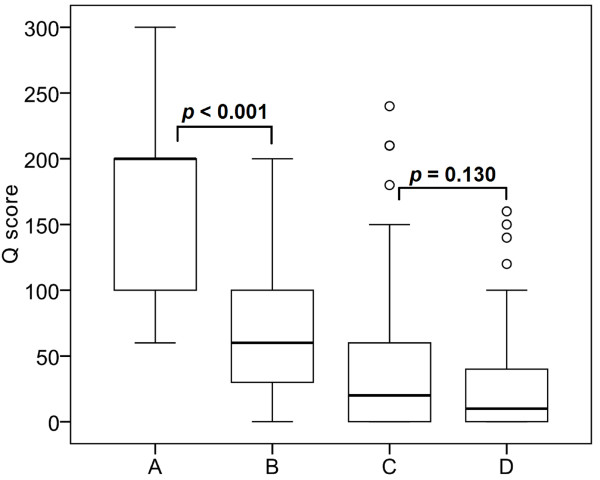
Comparison of Q scores of Beclin-1 in normal mammary glands and malignant CMTs. A. Cytoplasmic expression in normal mammary glands. B. Cytoplasmic expression in malignant CMTs. C. Nuclear expression in normal mammary glands. D. Nuclear expression in malignant CMTs. The middle lines of boxes show the median value, whereas top and bottom lines of boxes represent interquartile range. The ends of whiskers represent 10th and 90th percentiles. The outliers are indicated by open circles.